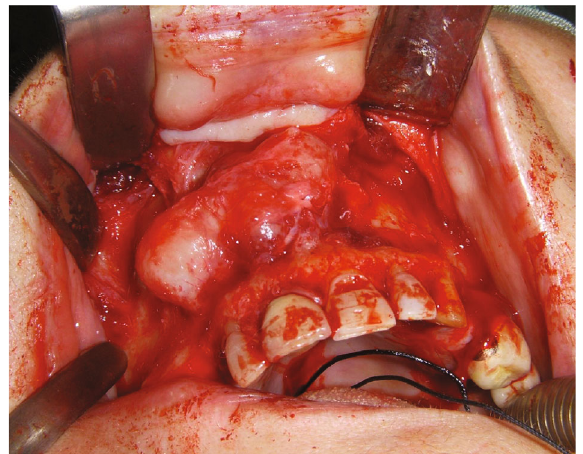
Figure 4: Intraoperative appearance of the neoplasm after the elevation of the mucoperiosteal fl ap, carried out until the exposure of the pyriform aperture.